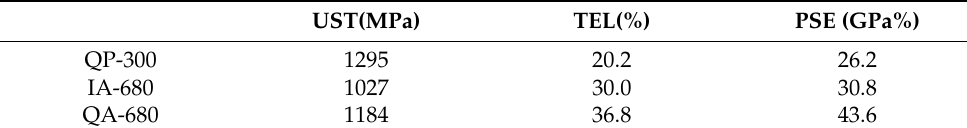
Table 2. The mechanical properties of the three processes.